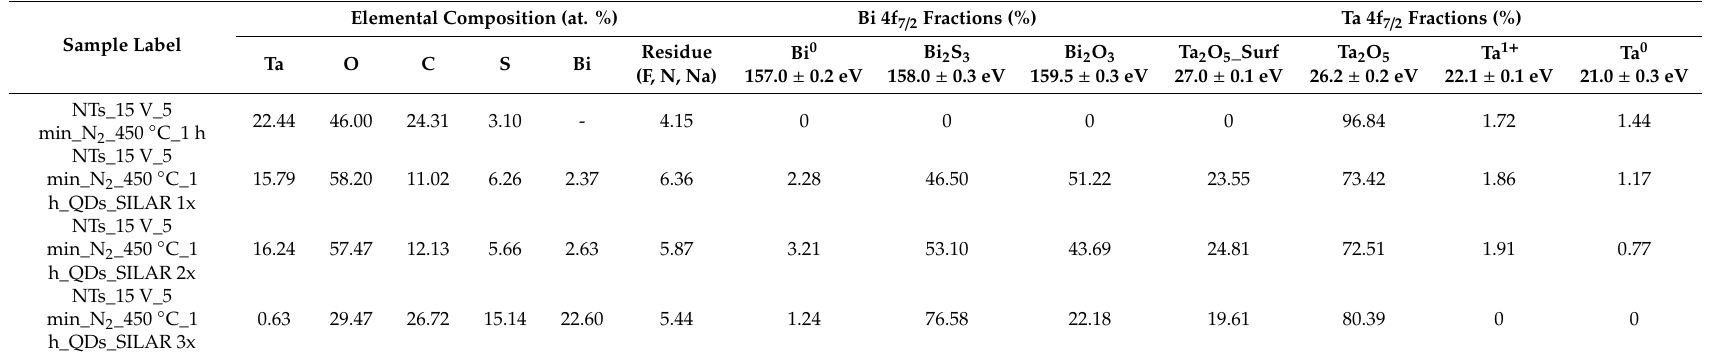
Table 2. Elemental composition (in at. %) of the surface layer of NTs_15V_5min_N 2 _450 ◦ C samples before and after subsequent SILAR cycles. The chemical states of Bi and Ta (in %) were evaluated after deconvolution of the Bi 4f and Ta 4f X-ray photoelectron spectroscopy (XPS) spectra, respectively. Sample